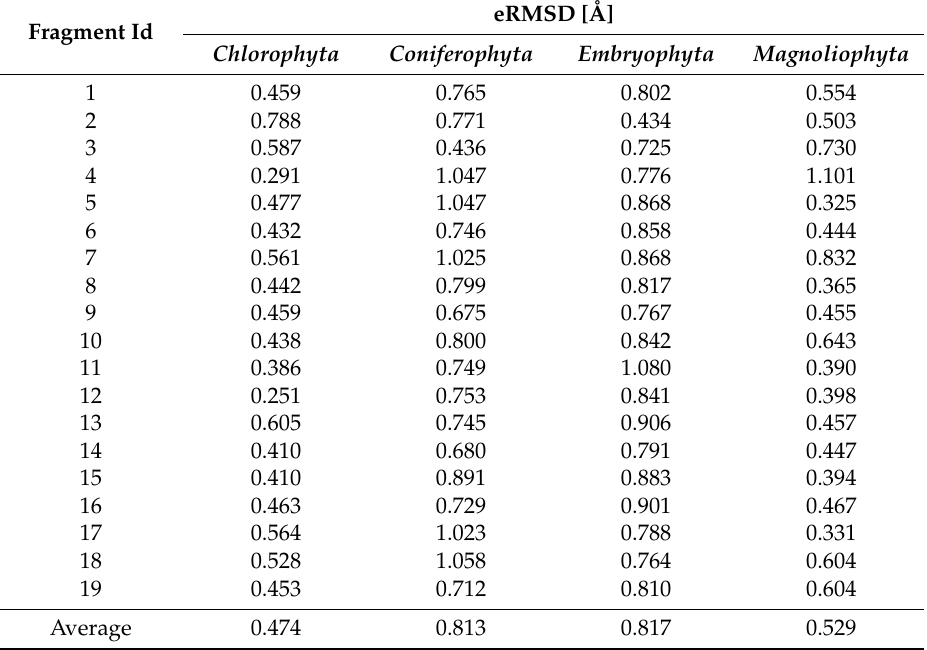
Table 6. eRMSD values of 3D fragments from each